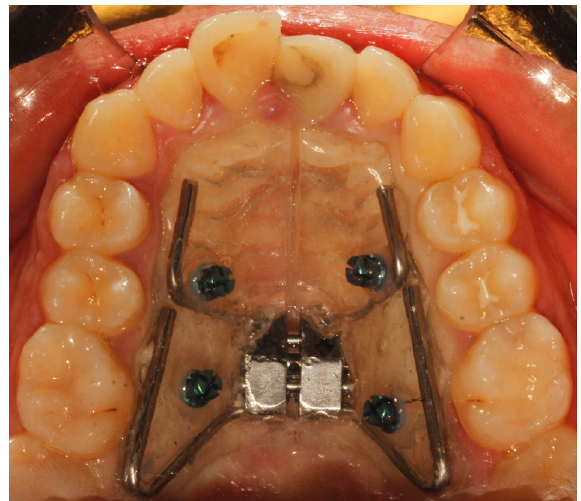
Figure 1. Mini-screw-assisted rapid maxillary